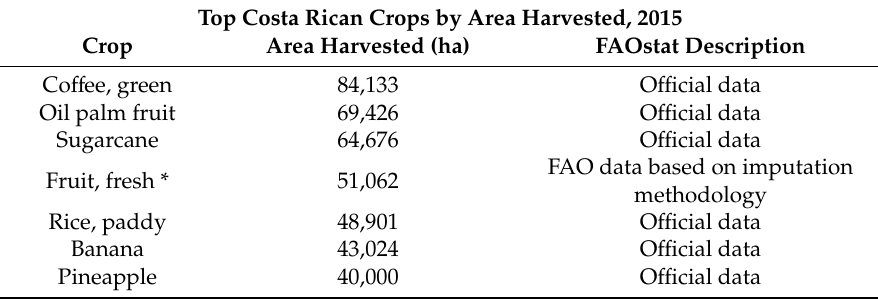
Table 2. FAO statistics of agricultural harvest in Costa Rica by